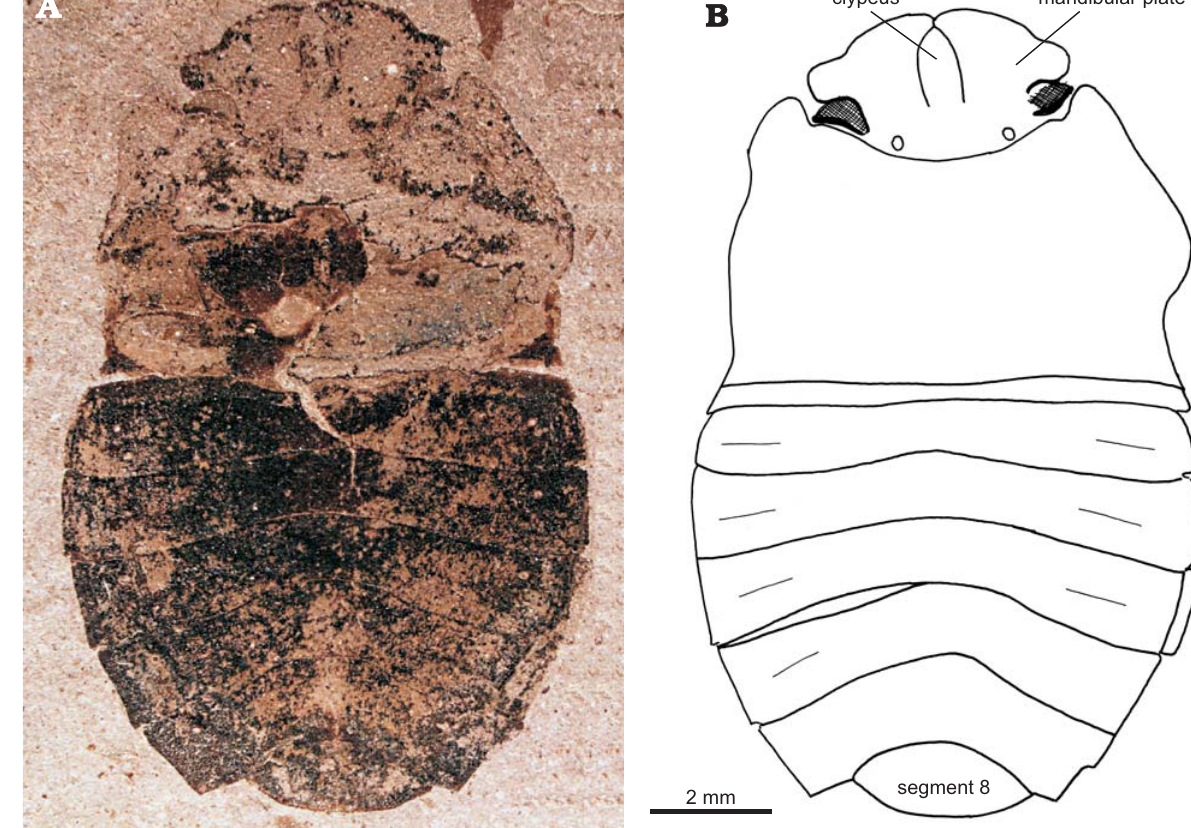
Fig. 1. Dorsal habitus of female of pentatomoid bug Chinchekoala qunita gen. et sp. nov., holotype MPEF-PI 944a from Laguna del Hunco (Chubut, Argentina); Ypresian, lower Eocene. Photograph ( A ), camera lucida drawing ( B